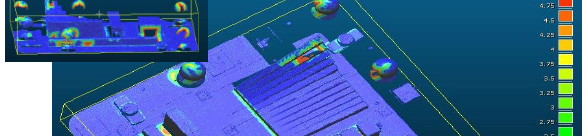
Figure 17 Plan of spheres A-F (green) and distance measurements (blue) seen in plan (Z+ axis)